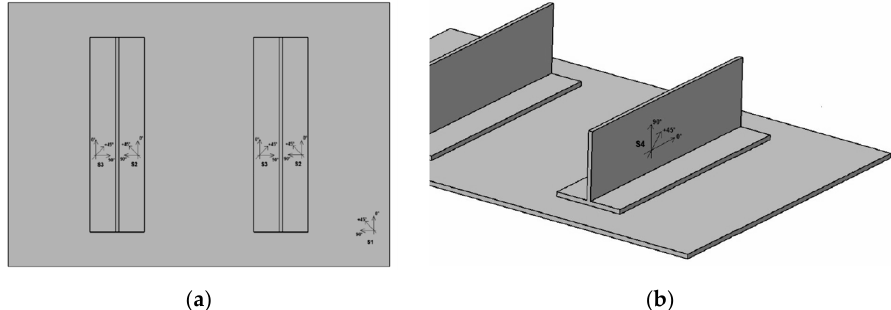
Figure 2. Carbon fiber reinforced plastic (CFRP) geometry: front view ( a ); dymetric view with thickness detail ( b ).